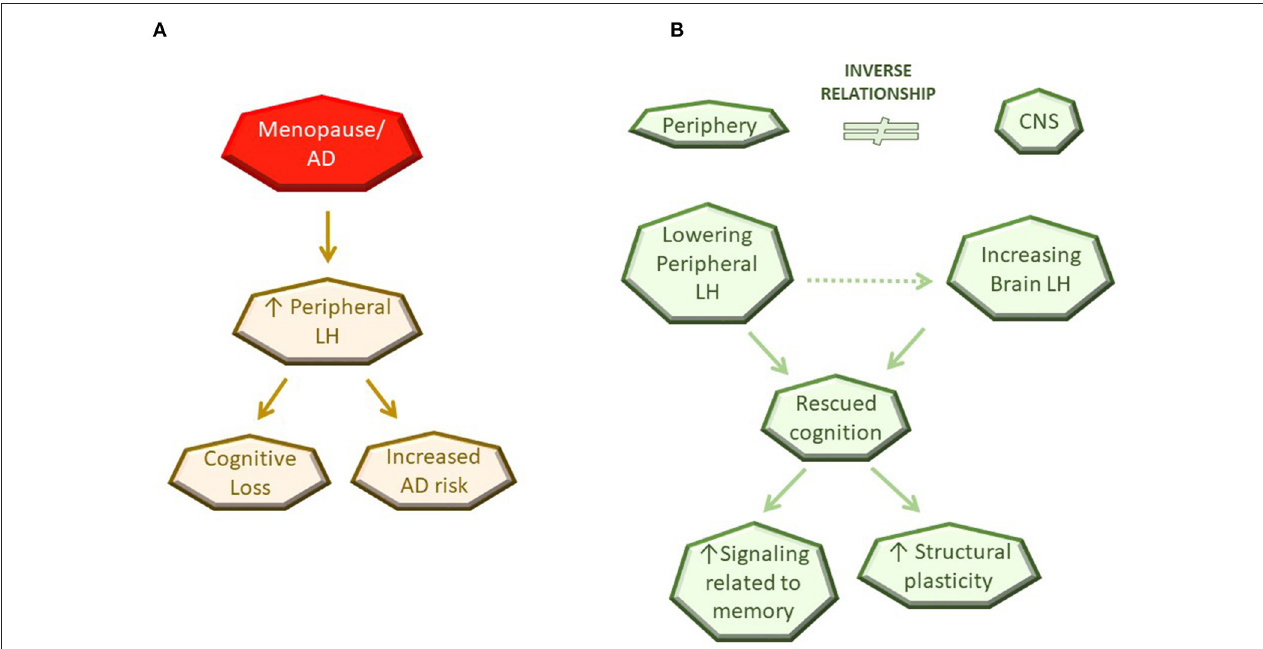
FIGURE 1 | Schematic diagram of current working model for LH action in the CNS. (A) Observation in the literature. (B) Potential mechanisms of LH action.